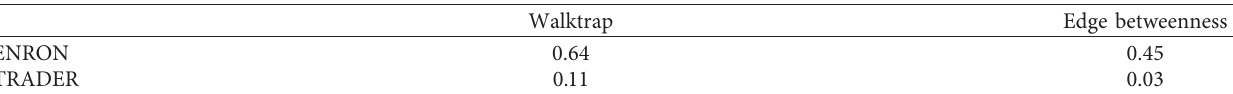
Table 2: Modularity of the Walktrap [65] and the edge-betweenness algorithms [66] for the ENRON and TRADER datasets.